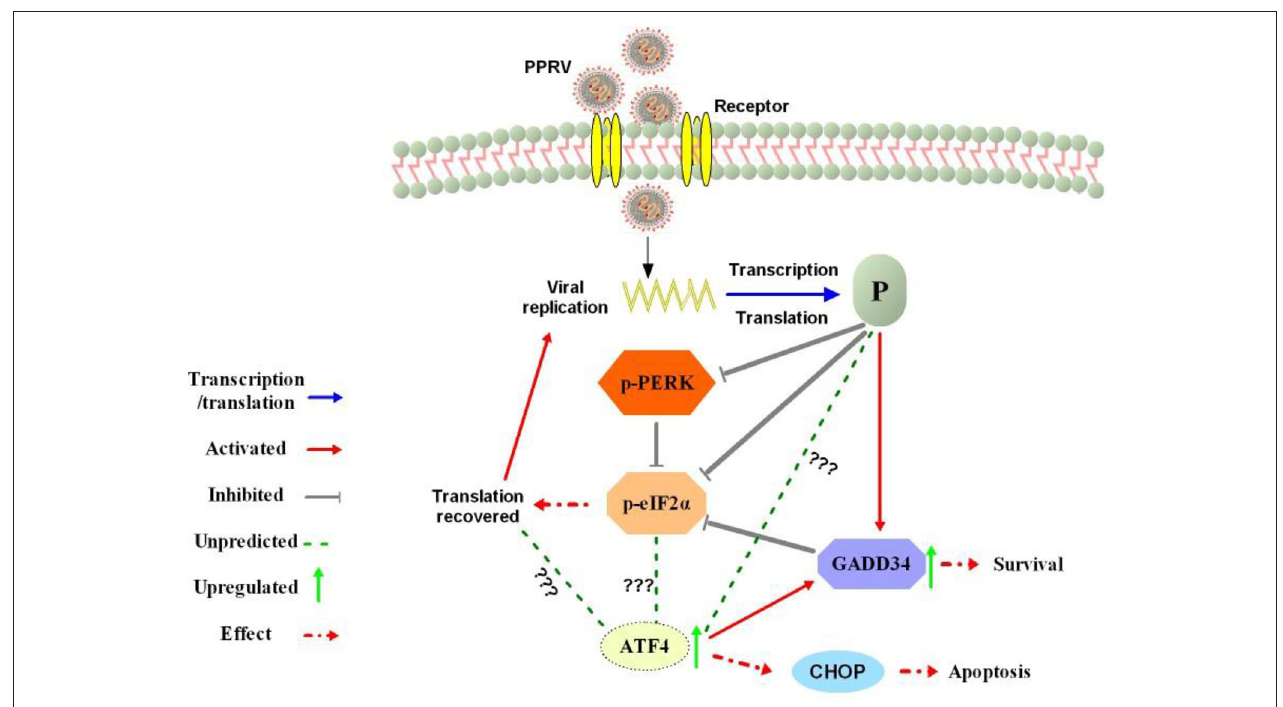
FIGURE 7 | Summary of the predicted modulation of eIF2 α phosphorylation by PPRV. After viral entry, the viral phosphoprotein (P) is produced through transcription and translation process. The P protein expression prevents PERK activation and activates cellular GADD34 to block eIF2 α phosphorylation through its negative feedback loop that attenuates signaling of integrated stress, thus leading to the cell survival and translation recovery. Translation recovery may then facilitate PPRV replication and viral protein synthesis. The mechanism by which PPRV P protein induces upregulation of ATF4 in the absence of PERK/eIF2 α phosphorylation requires further investigation. In fact, ATF4 was associated with cell death or survival decision through a selection of autophagy or apoptosis with or without CHOP expression.